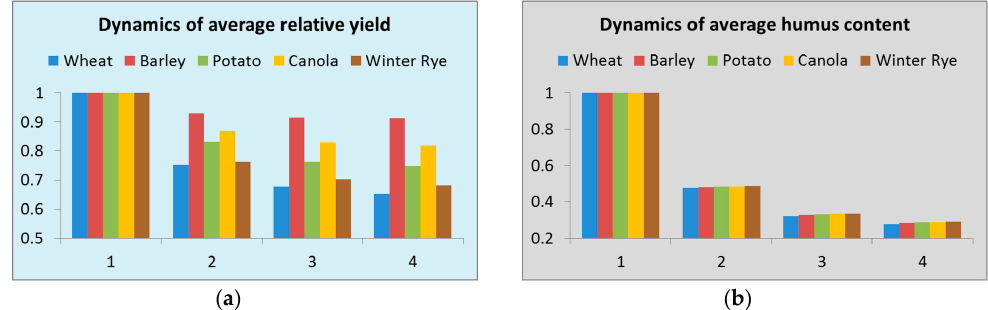
Figure 8. Results for base variant (no management): ( a ) Dynamics of average relative yield; ( b ) Dynamics of average humus content.